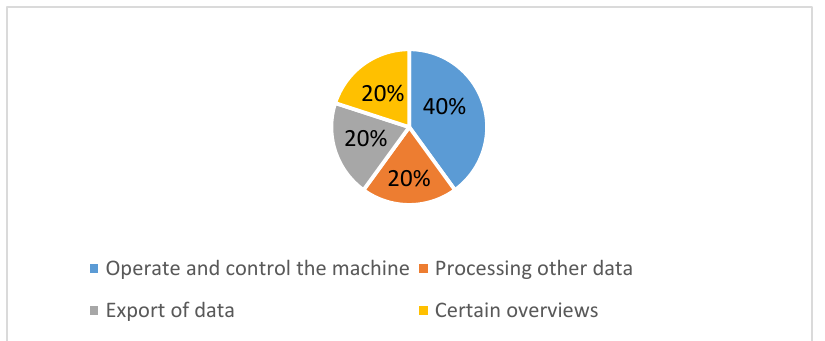
Figure 10. Missing features of the current FMIS.